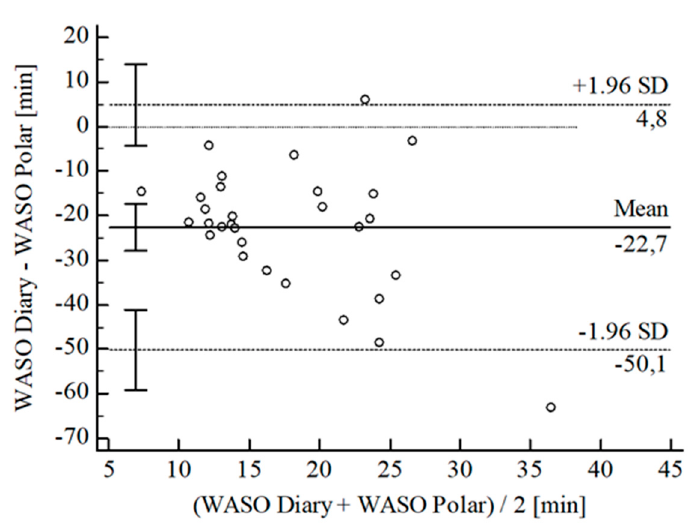
Figure 14. Bland-Altman Plot for WASO Polar ® vs. diary.